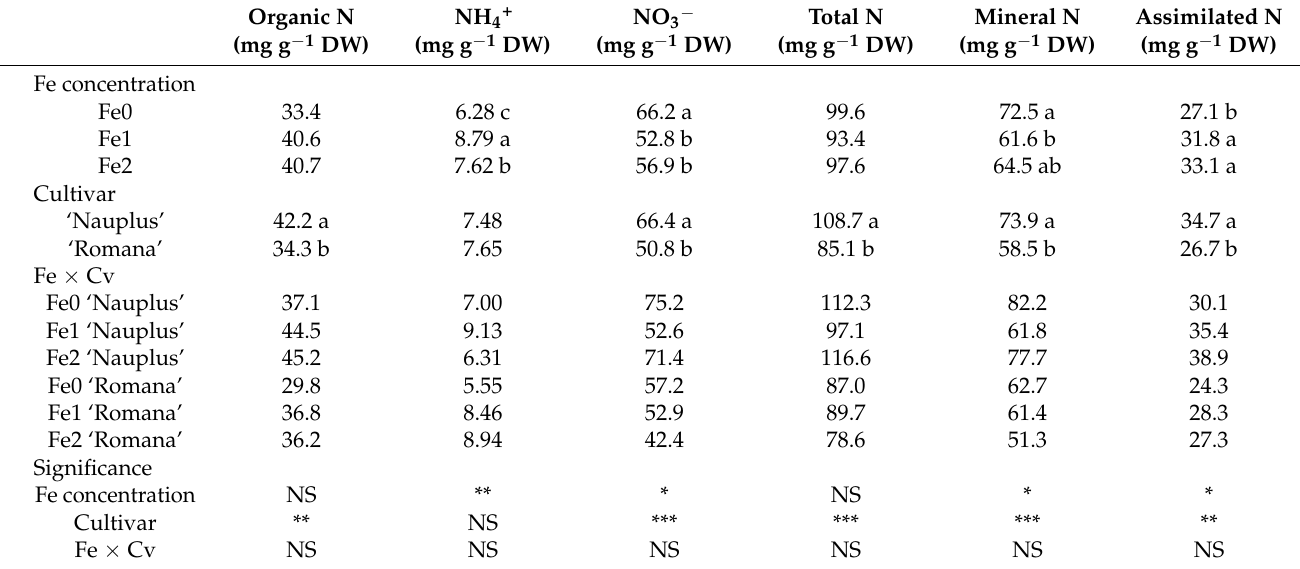
Figure 1. Fe content in the leaves of lettuce affected by the studied factors. Table 4. Forms of N of lettuce as affected by the studied